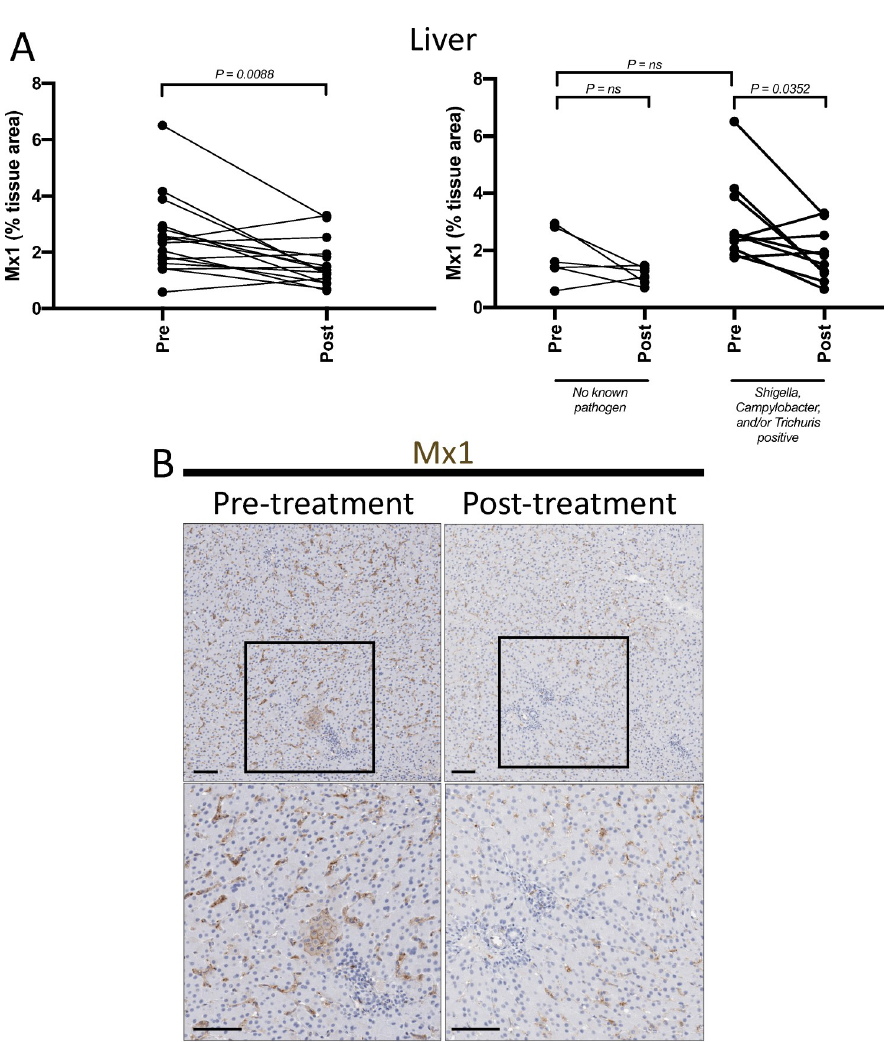
(IHC). (A) Animals with known enteric pathogens had a larger range of liver Mx1 expression before treatment and significant reduction following the short course multimodal treatment. (B) Representative images of Mx1-stained pre- treatment sections of liver (left-hand column) exhibited higher focal staining within tissue parenchyma, as well as increased staining within cells residing in the sinusoids. Treatment (right-hand column) led to a substantial reduction in Mx1 within both of these tissue compartments (i.e. tissue parenchyma and